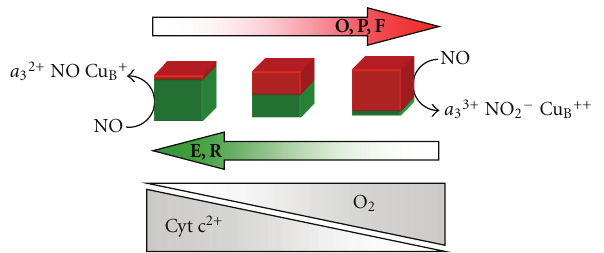
Figure 1: Dual-pathway model for the interaction of NO with mito- chondrial cytochrome oxidase. The nature of the interaction between NO and CcOX depends on the catalytic intermediates targeted, and these are di ff erently populated at di ff erent concentra- tions of O 2 and reduced cytochrome c . The oxidized intermediates O , P , F (see text) are overall more populated with increasing O 2 availability, and/or decreasing the concentration of reduced cytochrome c in the mitochondrion: these intermediates react with NO generating a nitrite-inhibited CcOX. The reduced species E and R (see text) buildup, instead, upon decreasing O 2 and/or increasing the concentration of reduced cytochrome c : upon reacting with NO, these intermediates generate a heme a 32+ -NO complex, in competition with